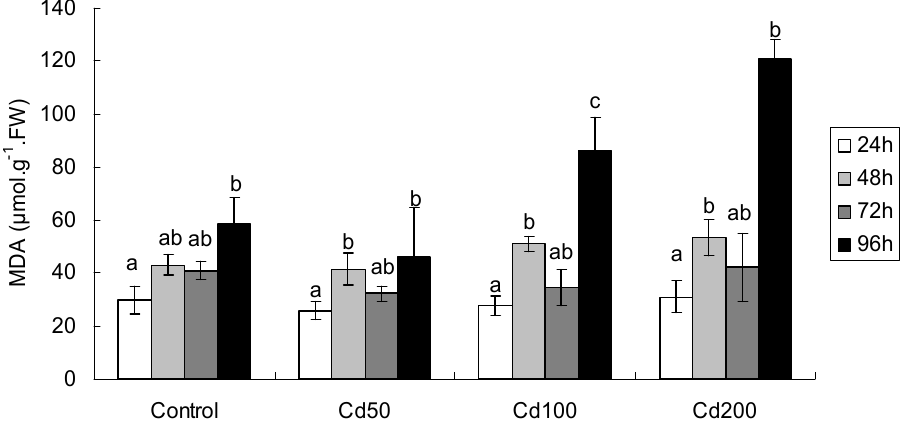
Figure 2. MDA concentration in germinating soybean seeds after different periods of exposure. All values are mean ± SD (n = 4). Values followed by lower case letters are significant at p <